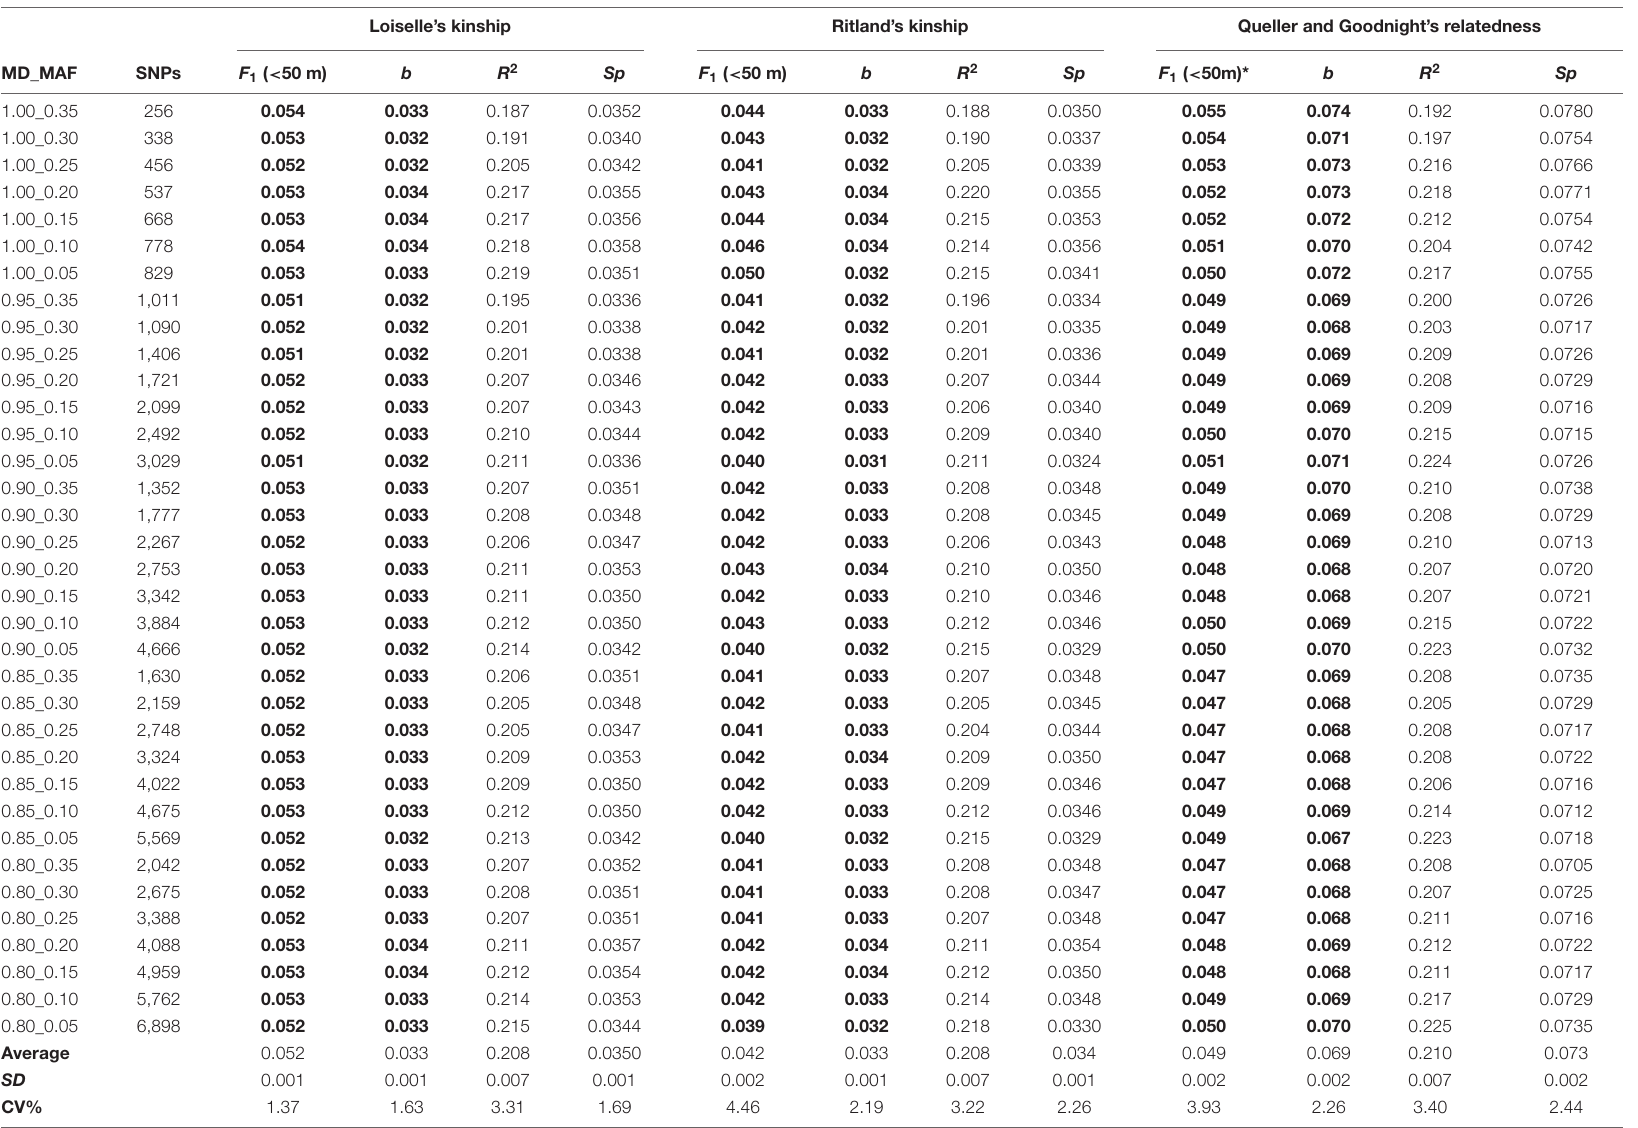
TABLE 1 | Effects of different amounts of missing data (MD) and minor allele frequency (MAF) on the estimates of pairwise relatedness statistics expressed by the mean F ij between individuals for the first distance class ( F 1 ) for the empirical data set ( n = 50; adults and seedlings of Dinizia jueirana-facao